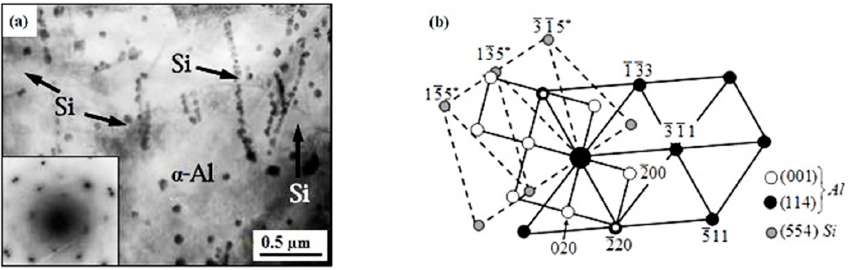
Figure 2. Transmission electron microscopy (TEM) image of the initial Al-7%Si alloy: ( a ) a bright-field image and its microdiffraction pattern; ( b ) an indexed scheme of section ( a